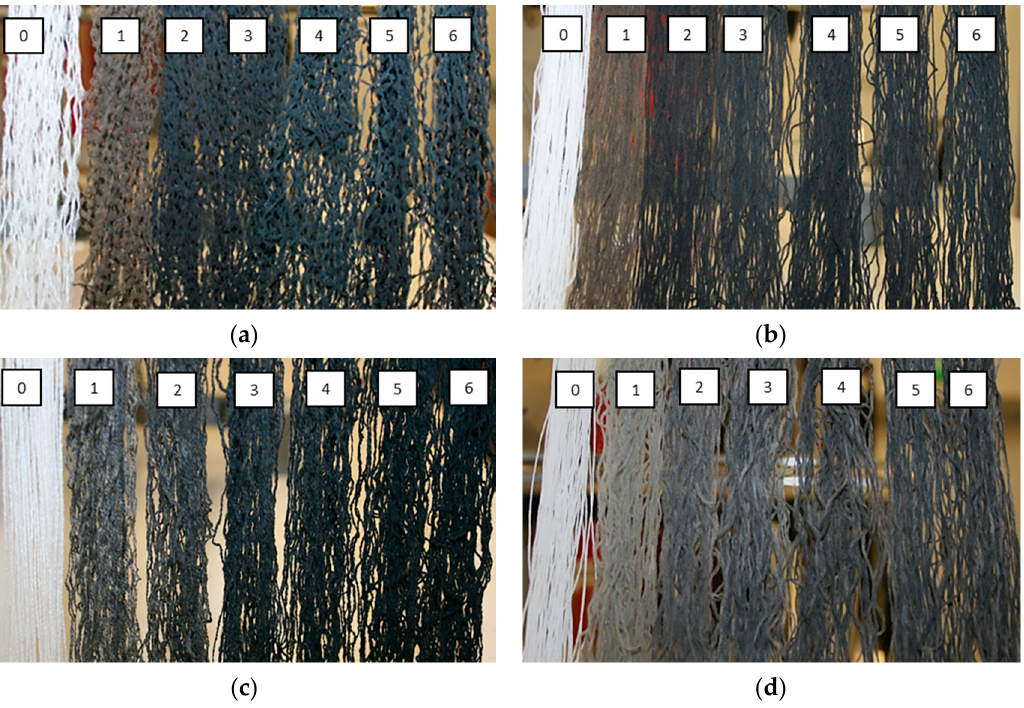
Figure 3. Example of modified synthetic fibers from left to right range from raw to treated after 6 cycles: ( a ) PA6, ( b ) PA66, ( c ) PAN, and ( d ) PES.